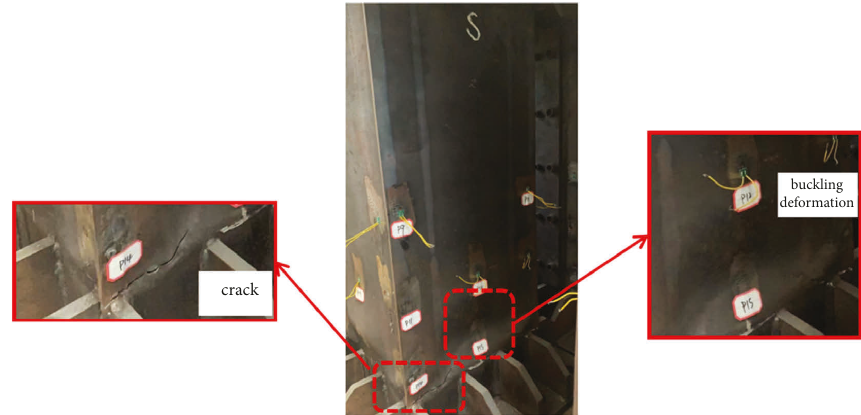
Figure 7: Failure mode of specimen